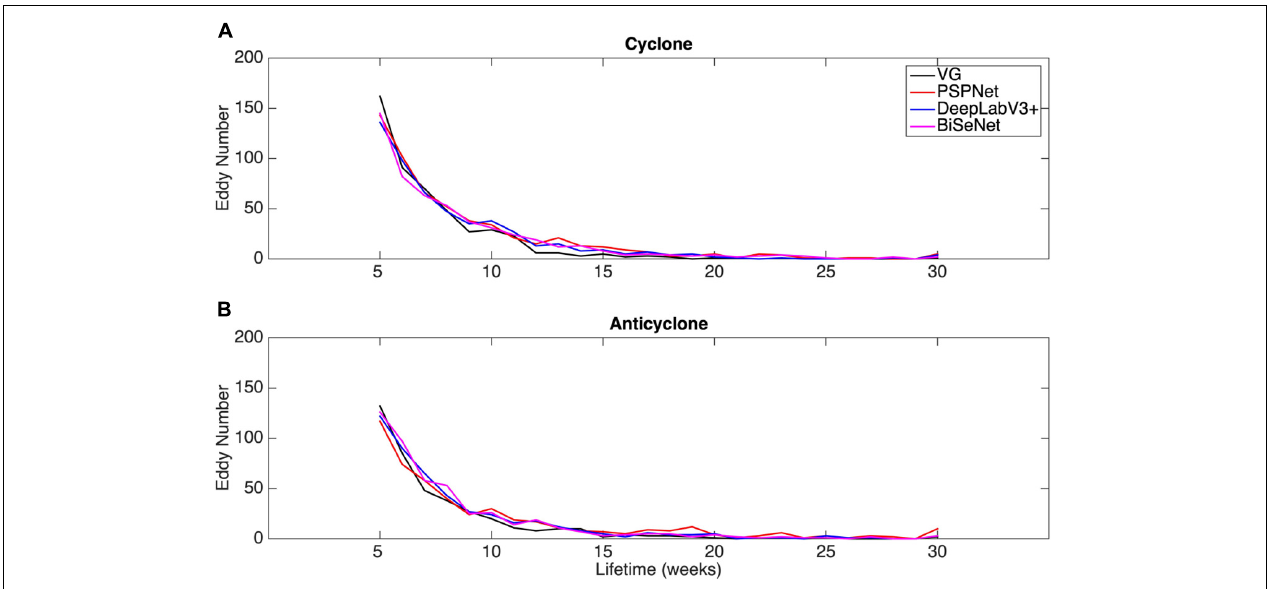
FIGURE 8 | Lifetime distribution of eddies identified by the VG (black), PSPNet (red), DeepLabV3+ (blue), and BiSeNet (purple) algorithms in the STCC region during 2015. (A) Cyclones; (B) anticyclones.